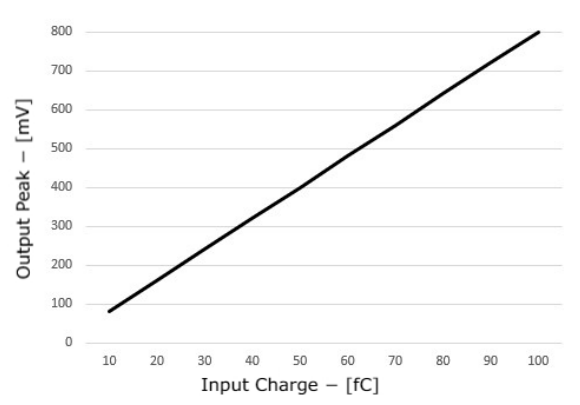
Figure 12. Sensitivity (Vout/Qin) at the output of the analog section.